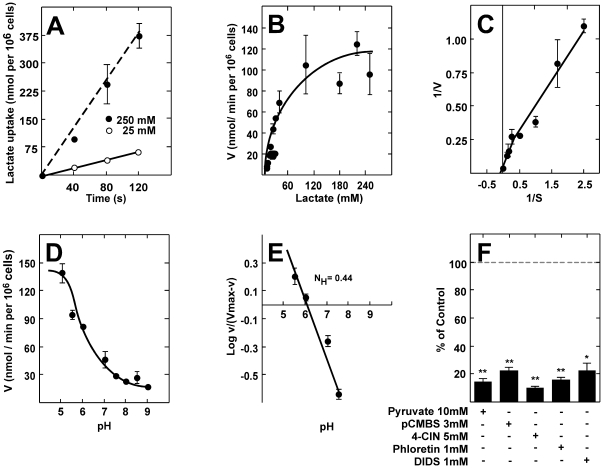
Functional characterization of cultured tanycytes.
A, 25 mM L-lactate (open circles) and 250 mM L-lactate (closed circles) transport at 4°C and pH 7.0 over time. B, Kinetic parameters of L-lactate transport in tanycyte cultures at 1 min, 4°C, and pH 7.0. C, Double-reciprocal plot of MCT1: (Km, 6 mM; Vmax, 13 nmol×106 cells/min) and MCT4: (Km, 48 mM; Vmax, 100 nmol×106 cells/min). D, Dependence of lactate uptake on pH (0.1 mM L-lactate, 4°C). E, Hill plot to analyze the dependence of lactate uptake on pH. F, Analysis of lactate transport in the presence of various inhibitors co-incubated for 1 min (0.1 mM lactate, 4°C, pH 7.0). Results represent the mean ± SD of three independent experiments. **p<0.001, one tailed t-test.